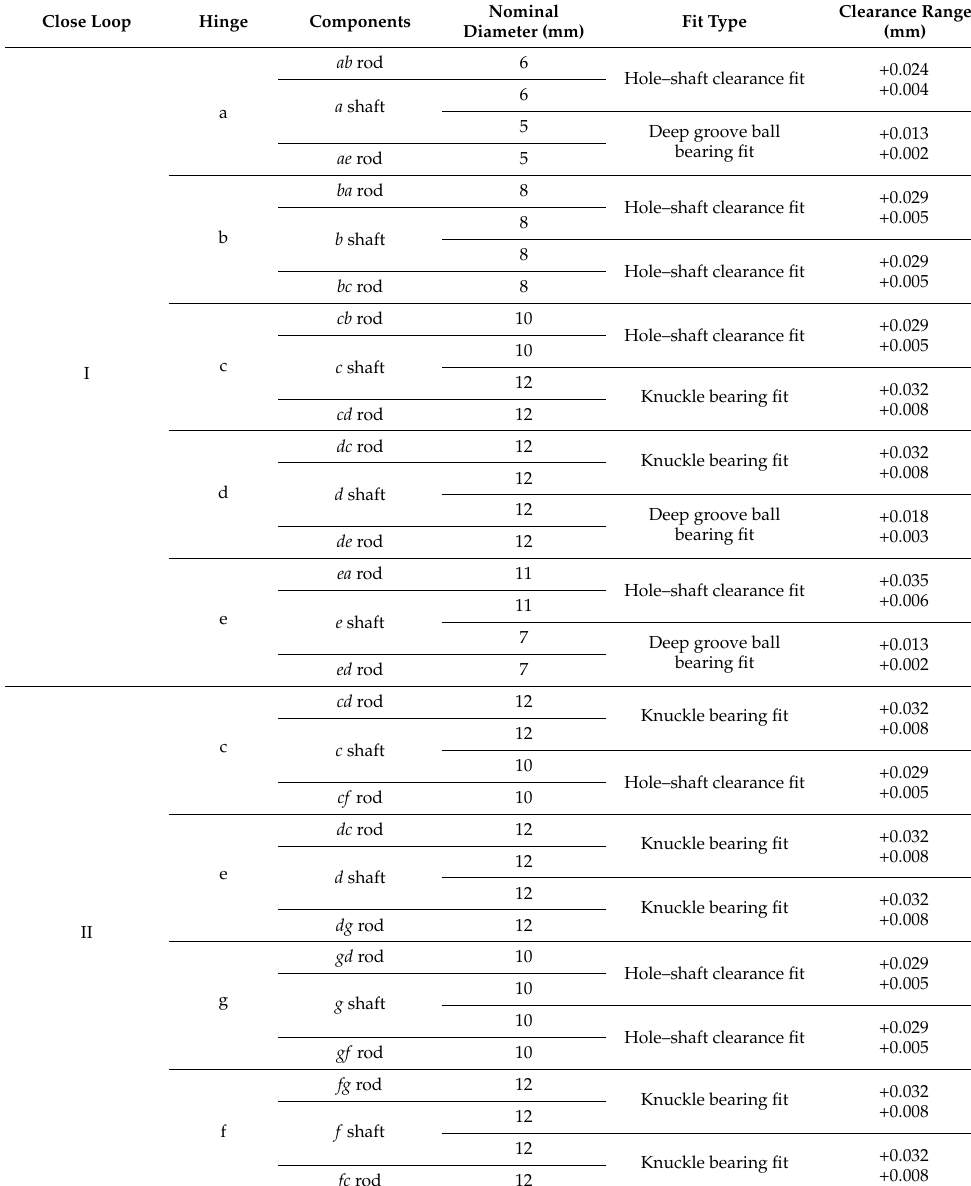
Figure 14. LSDM hinge types. Table 4. Hinge clearances in the LSDM.